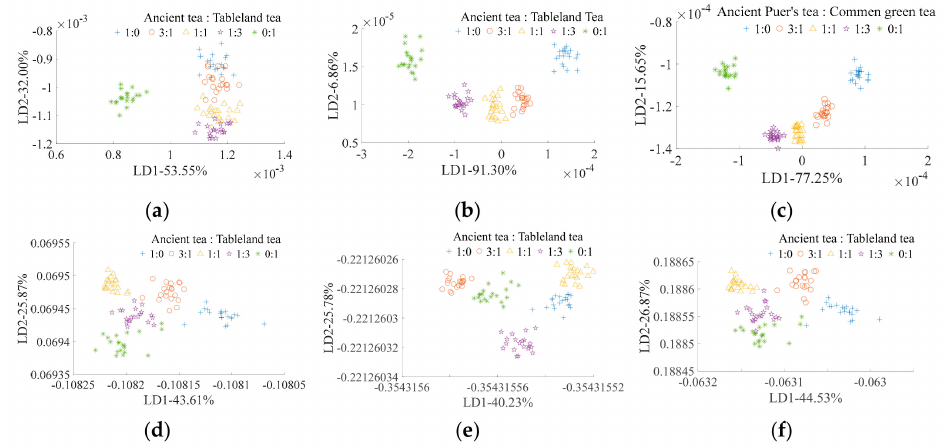
Figure 5. LDA for ancient Pu’er tea discrimination based on E-nose. ( a – c ) are traditional feature extraction; ( d – f ) are CNN feature extraction; ( a , d ) are E-nose detection; ( b , e ) are VIS / NIR spectrometer detection; and, ( c , f ) are multi-information fusion